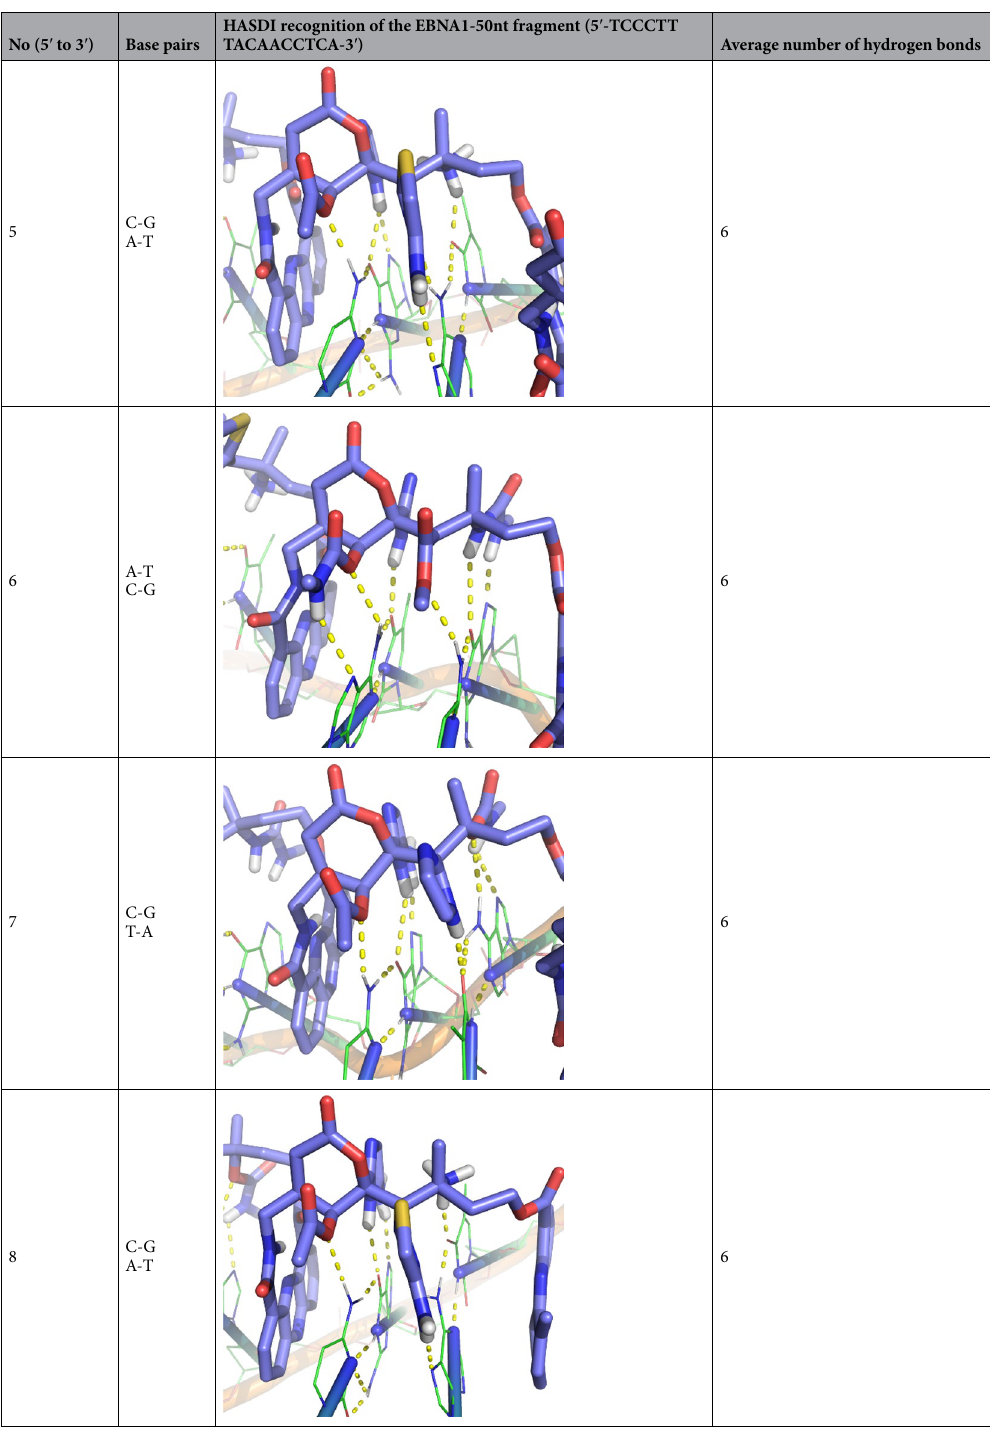
Table 2. Features of the interaction of HASDI with the sequence 5 ′ -TCC CTT TAC AAC CTCA-3 ′